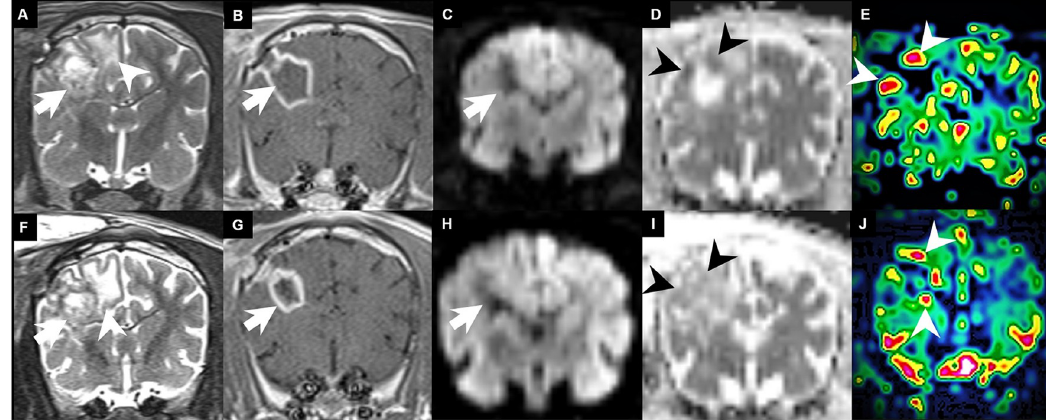
Fig 3. Longitudinal follow-up imaging in a canine brain tumour model. (A) After one week of surgery, a tumour was identified at the right frontoparietal area (arrow) with peripheral oedema (arrowhead) on the T2-weighted image. (B) The implanted glioblastoma multiforme (GBM) shows a large necrotic mass with peripheral enhancement similar to that seen in humans (arrow) on the contrast-enhanced T1-weighted image. (C-D) The mass shows diffusion restriction at the peripheral enhancing portion of the tumour (arrowhead) on the diffusion-weighted image (C) and apparent diffusion coefficient image (D). (E) There was also increased CBV (arrowhead) in the peripheral enhancing portion of the GBM on the dynamic susceptibility contrast-enhanced perfusion- weighted image. (F-G) On the two-week follow-up MRI, the peripheral enhancing lesion persists (arrow) with perilesional oedema (arrowhead) on the T2-weighted image (F) and contrast-enhanced T1-weighted image (G), and diffusion-weighted imaging does not show definite restriction in the peripheral portion (H-I) . (J) However, there was still increased cerebral blood volume on the relative cerebral blood volume map (arrowhead) on the dynamic susceptibility contrast-enhanced perfusion-weighted image.